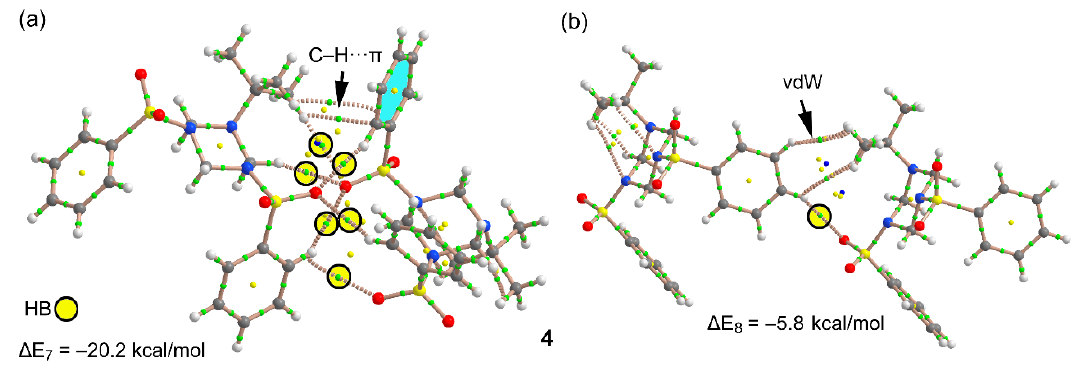
Figure 12. ( a , b ) Distribution of bond, ring and cage critical points (green, yellow and blue spheres, respectively) and bond paths in two dimers of complex 4 . The C–H ··· O bonds are highlighted.